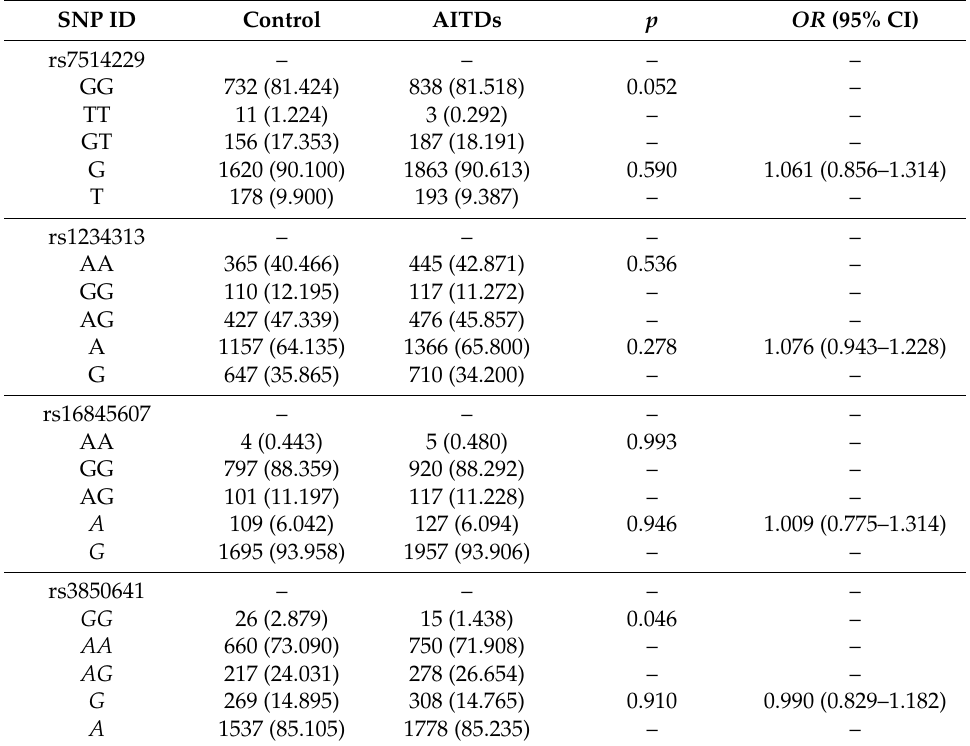
Table 2. Allele and genotype distribution of TNFSF4 in AITDs patients and controls.